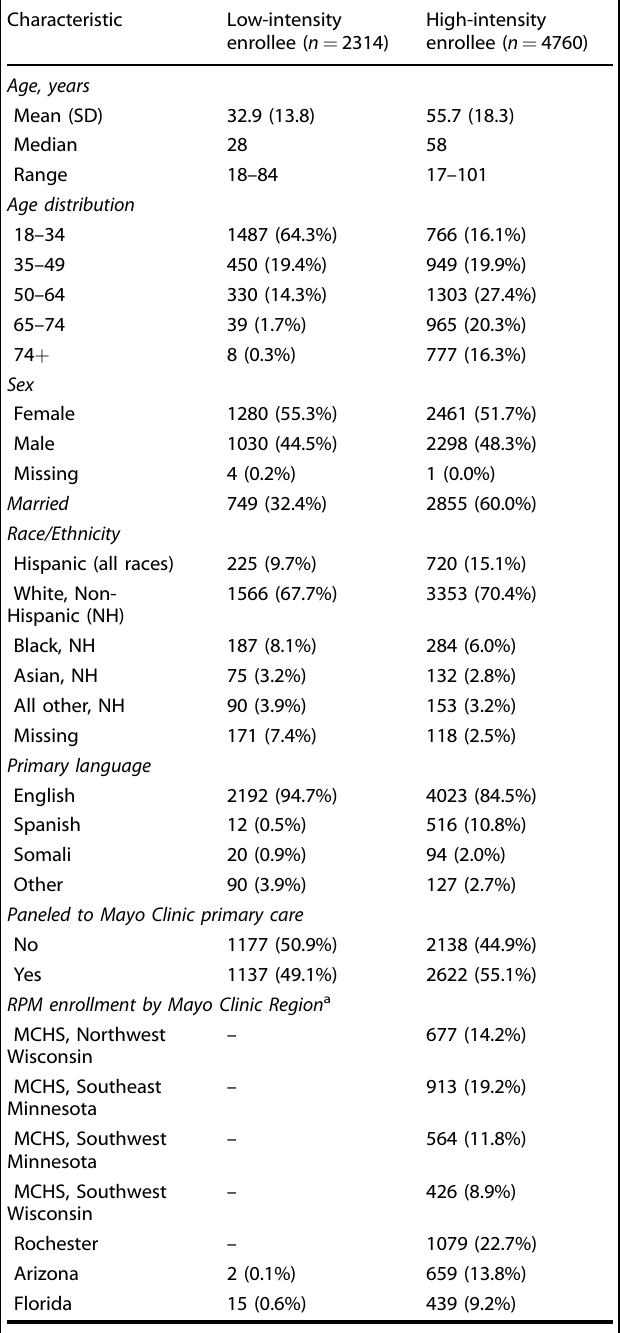
Table 2. Patient demographics and